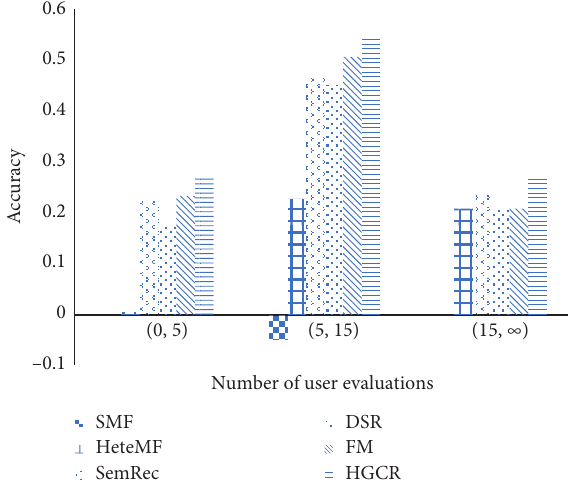
Figure 8: Performance of cold start on Douban